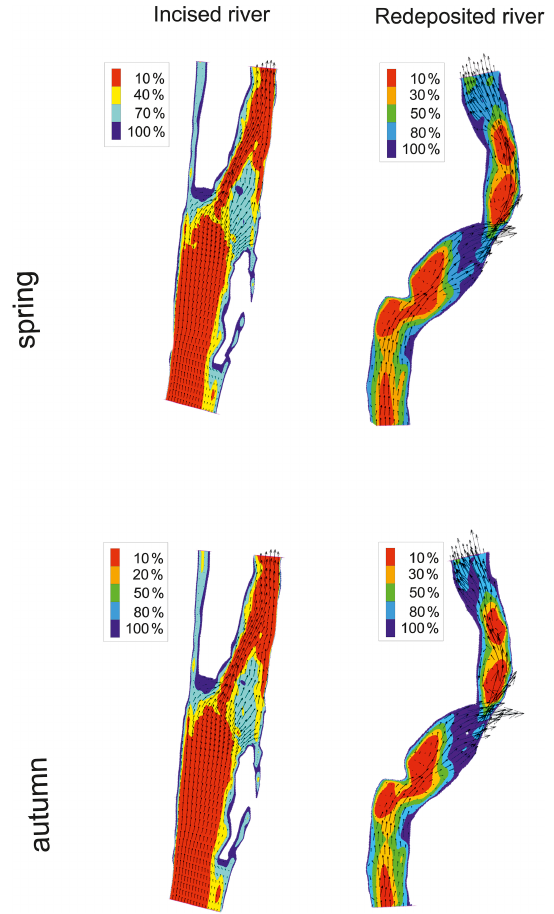
Figure 8. Probability of habitat suitability calculated as a percent- age of the occurrence of optimal conditions of macroinvertebrate habitat suitability for calculated Q env in spring and autumn seasons in incised (Raba) and redeposited (Ropa)